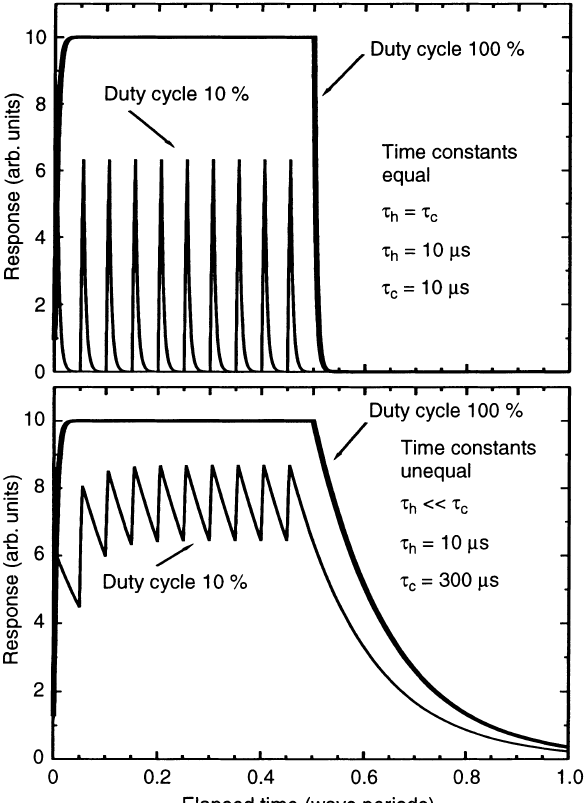
of 10 and 100% duty cycle. Upper panel : heating and cooling time constants of ionospheric current both (cid:136) 10 l s. Lower panel : heating time constant (cid:136) 10 l s. Cooling time constant (cid:136) 300